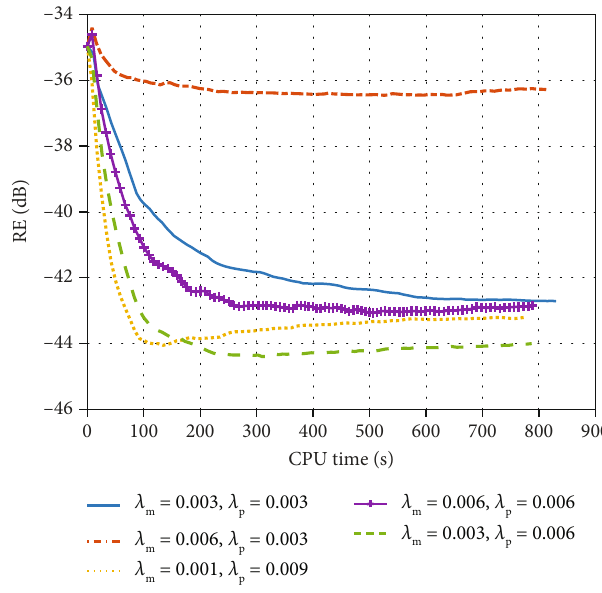
Figure 3: The RE of di ff erent weighting parameters.